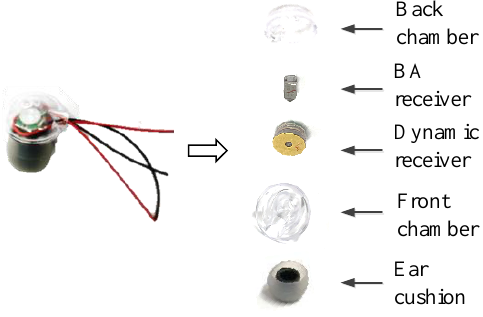
Figure 10. Components of the earphone.